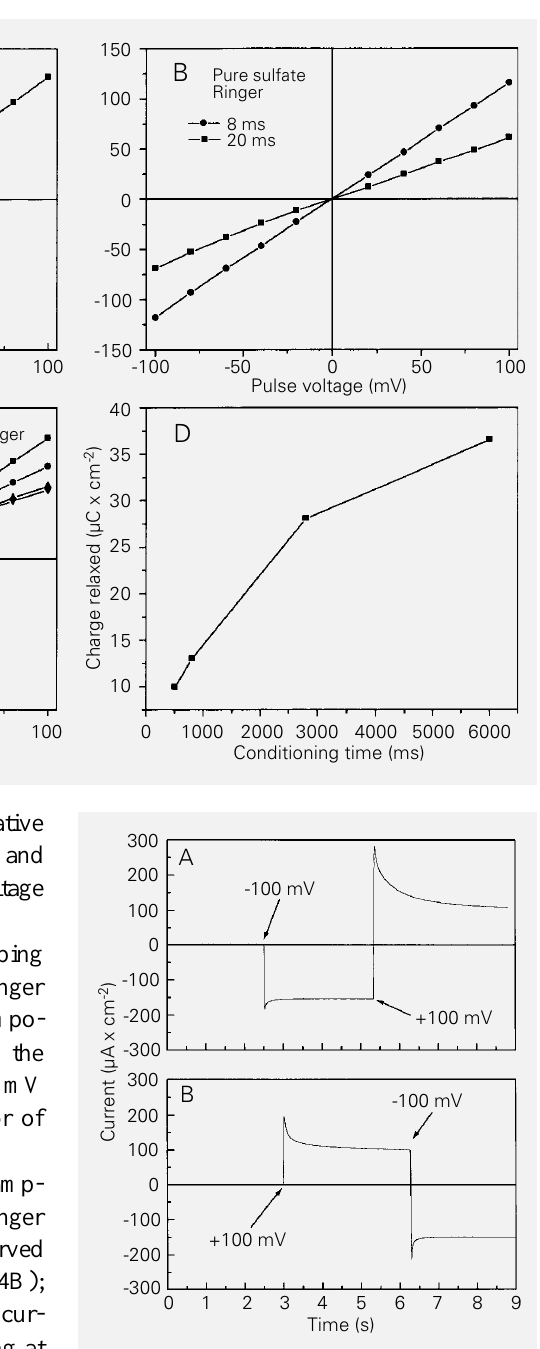
the inhibitory effect of a positive pulse on the current was instantaneously released upon inverting the voltage. The current vs voltage characteristics of the skin stimulated by sinusoidal voltages were studied at frequencies between 0.02